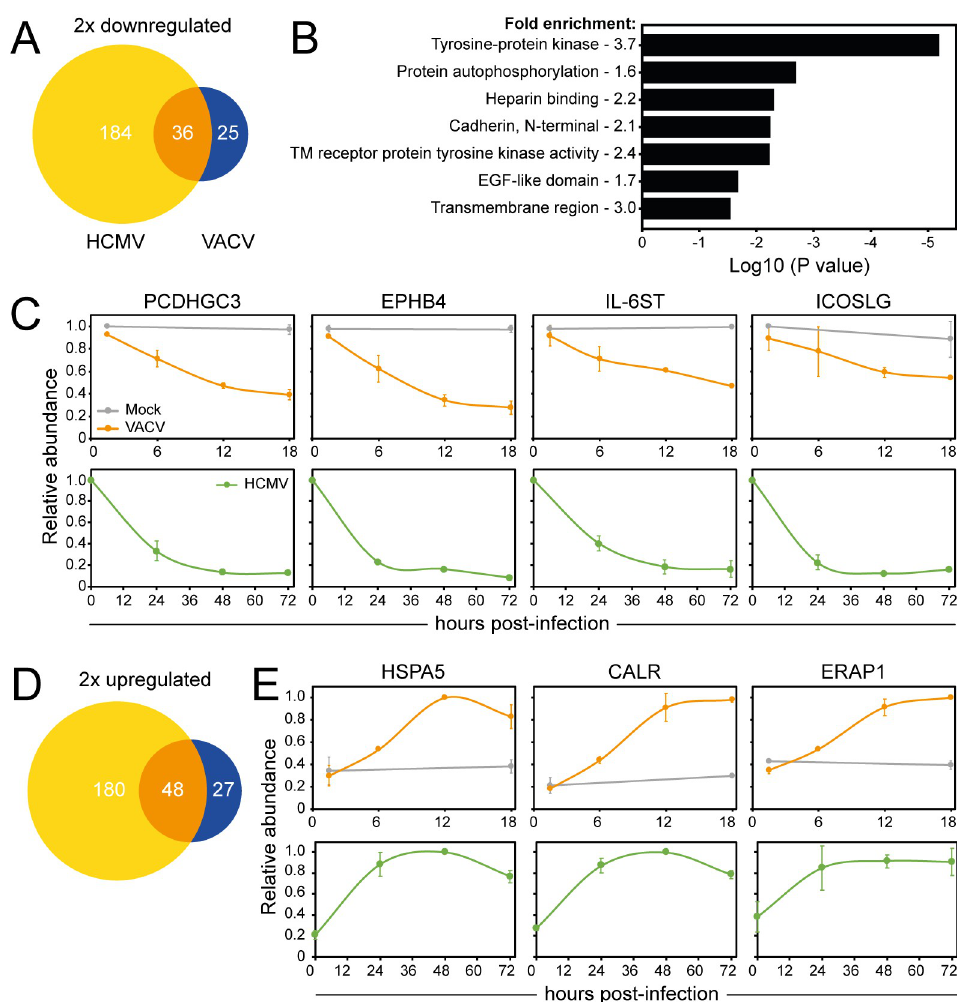
Fig 9. HCMV and VACV commonly target a subset of PM proteins. ( A ) Overlap of proteins downregulated according to ‘sensitive’ criteria after infection with VACV or HCMV (S6A Table). ‘Sensitive’ criteria HCMV PMP (n = 2) [29]: human PM- (GO terms PM/CS/XC/ShG) proteins quantified in a single or both replicates and showing on average > 2 FC at any time-point (24, 48, 72 hpi) compared to (average of) mock sample(s). ( B ) Functional enrichment within proteins commonly downregulated from cell surface during VACV or HCMV infection (‘sensitive’ criteria). A background of all proteins detected in at least one replicate of both PMP VACV and PMP HCMV was used. Shown are representative terms from each cluster with a Benjamini-Hochberg-corrected p-value of < 0.05 (S6B Table). ( C ) Temporal profiles of selected proteins commonly downregulated from the cell surface after VACV or HCMV infection. ( D-E ) As panel A/C, respectively, using proteins upregulated by ‘sensitive’ criteria (S6C Table).